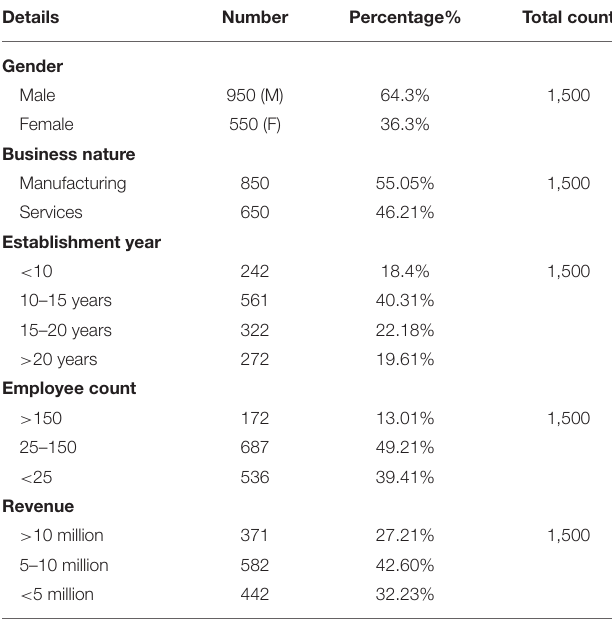
TABLE 3 | Demographic details of the